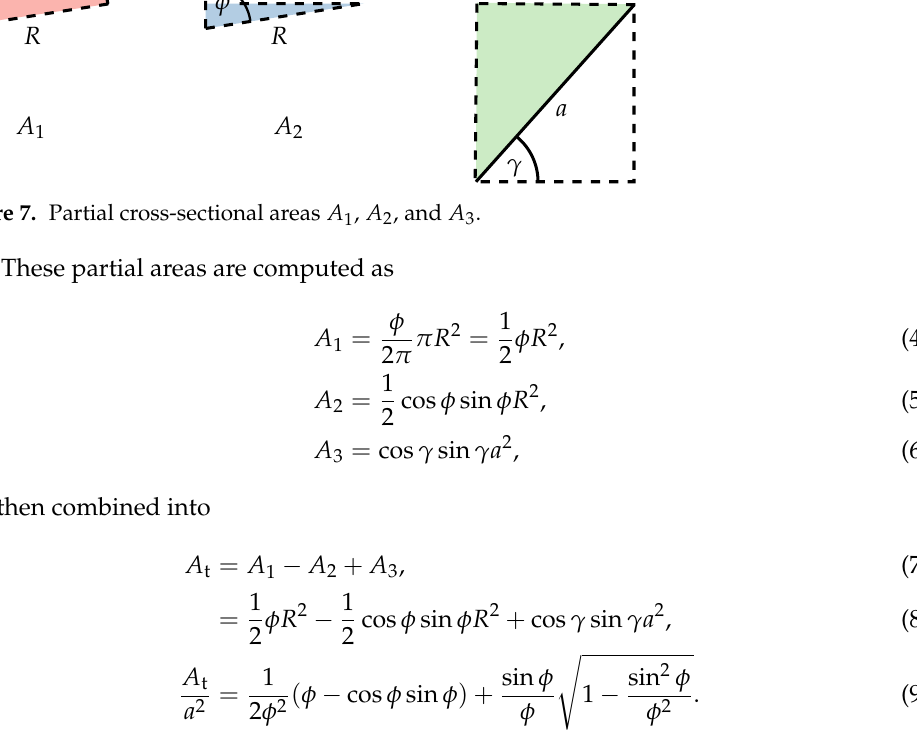
and then combined into